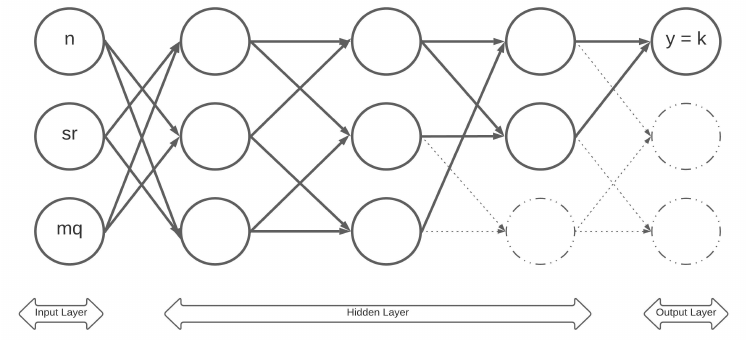
Figure 5. GMDH Model with three inputs and one output.